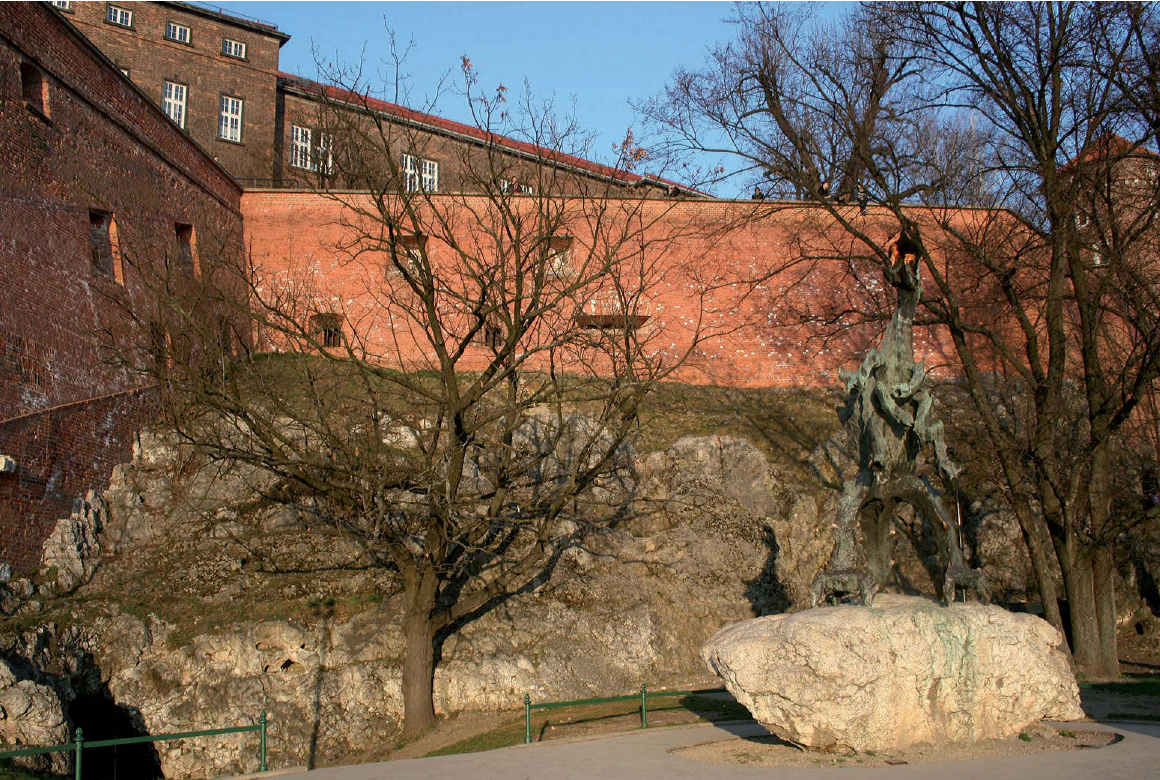
Fig. 8. Recultivated landscape – the Wawel hill breach and the Wawel